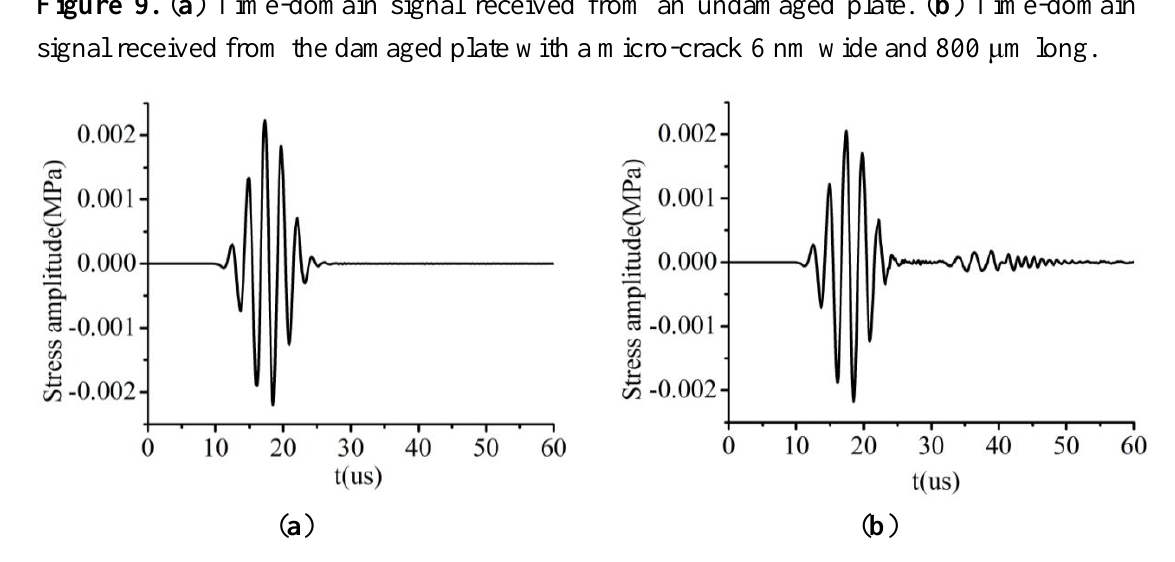
Figure 10. Superimposed time-domain signals. The blue curve represents the signal from the undamaged plate, and the red curve represents the signal from the plate with a micro-crack 6 nm wide and 800 μm